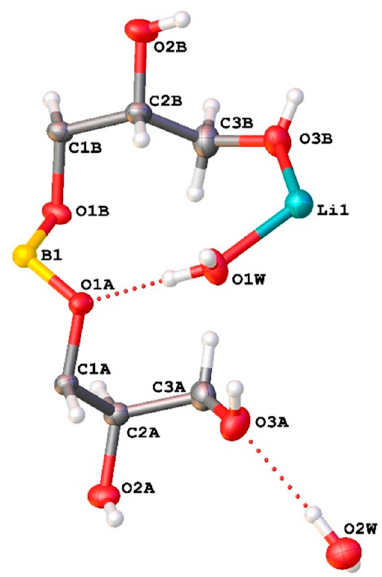
Figure 1. View of the asymmetric unit of compound LiM 2 B.